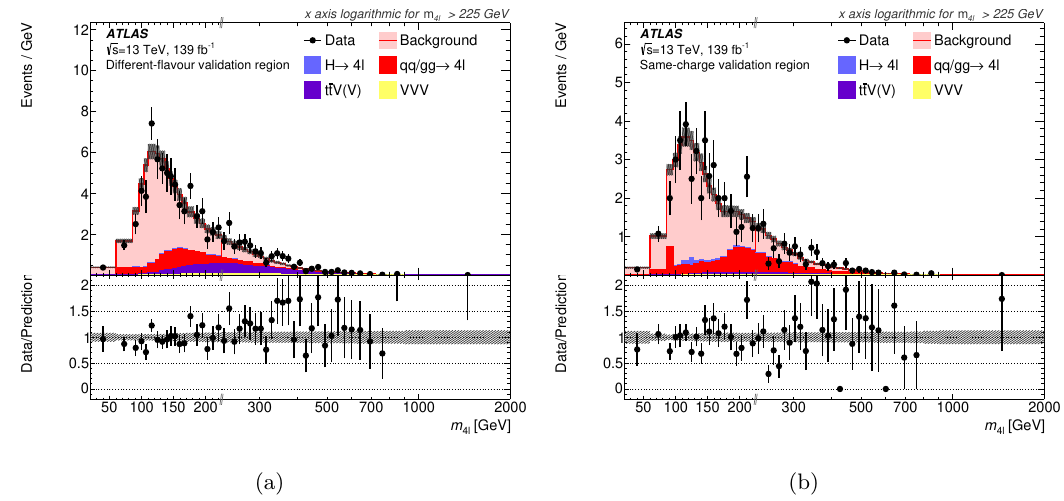
Figure 2 . Observed m 4 ‘ distribution compared to the data-driven estimation of the background from non-prompt leptons in the (a) different-flavour and (b) same-charge validation regions. Con- tributions from events with four prompt leptons, obtained from simulation, are also shown. The hashed band represents the total uncertainty on the background estimation. The x -axis is on a linear scale until m = 225 GeV, where it switches to a logarithmic 4 ‘